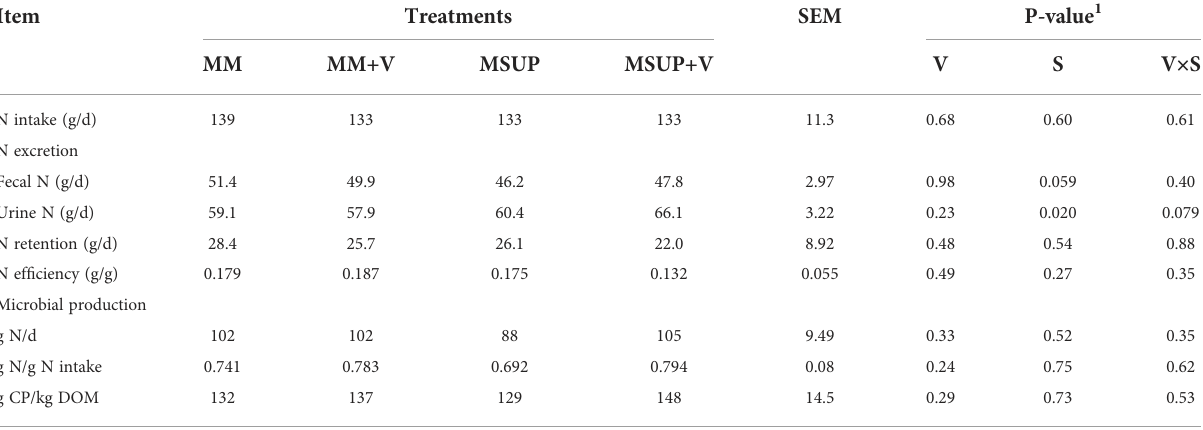
TABLE 6 Effects of feeding multiple supplement and, or virginiamycin on N utilization characteristics of heifers fed a high-quality tropical